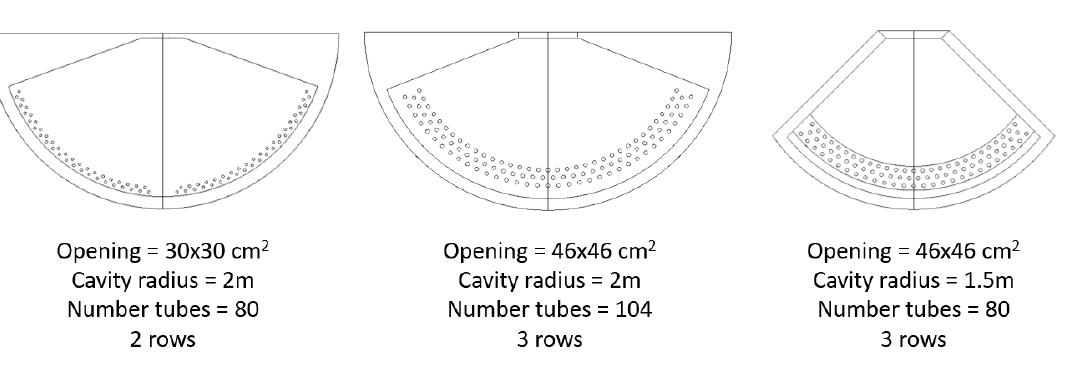
Figure 3. ( left ) Initial reactor design; ( middle ) Second reactor design; ( Right ) Final reactor Figure 3. (left) Initial reactor design. (middle) Second reactor design. (Right) Final reactor design.